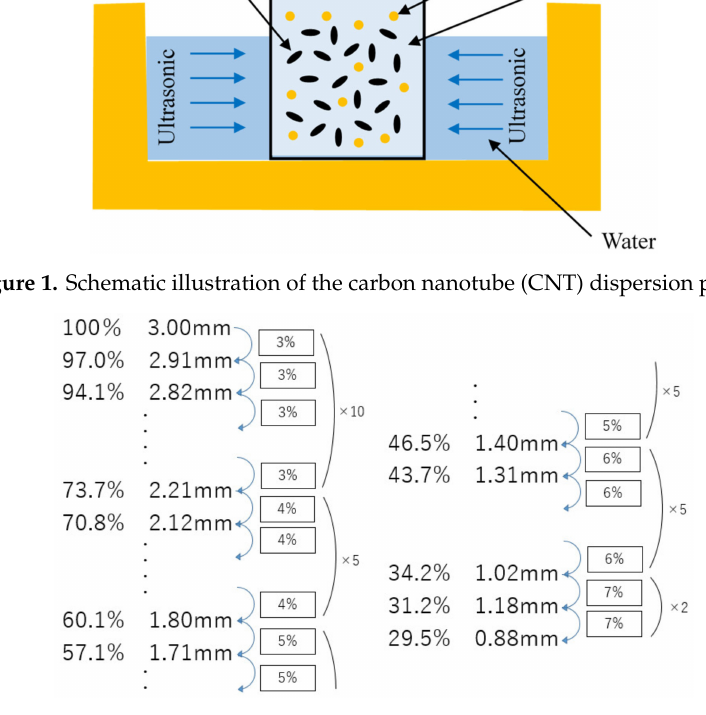
Figure 2. Repeated hot-rolling